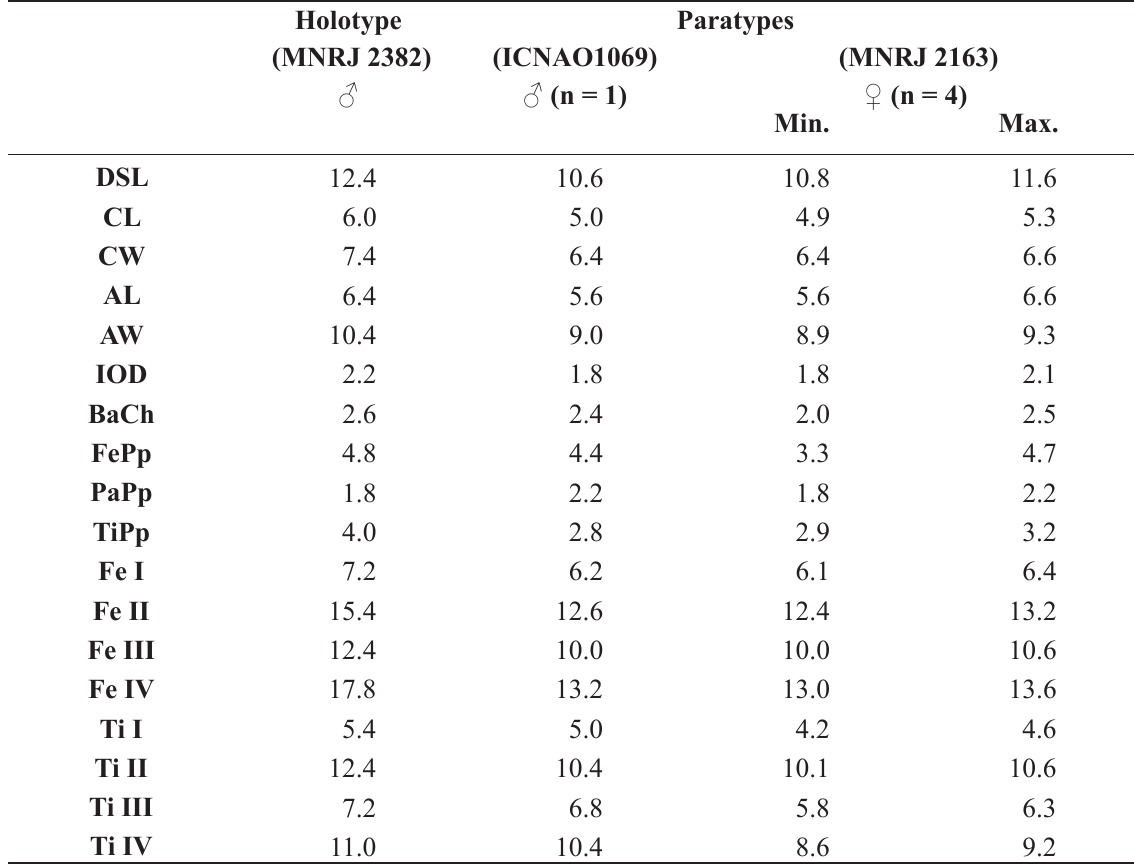
Table 1. Phalangodus briareos sp. nov., measurements of body and appendage, in